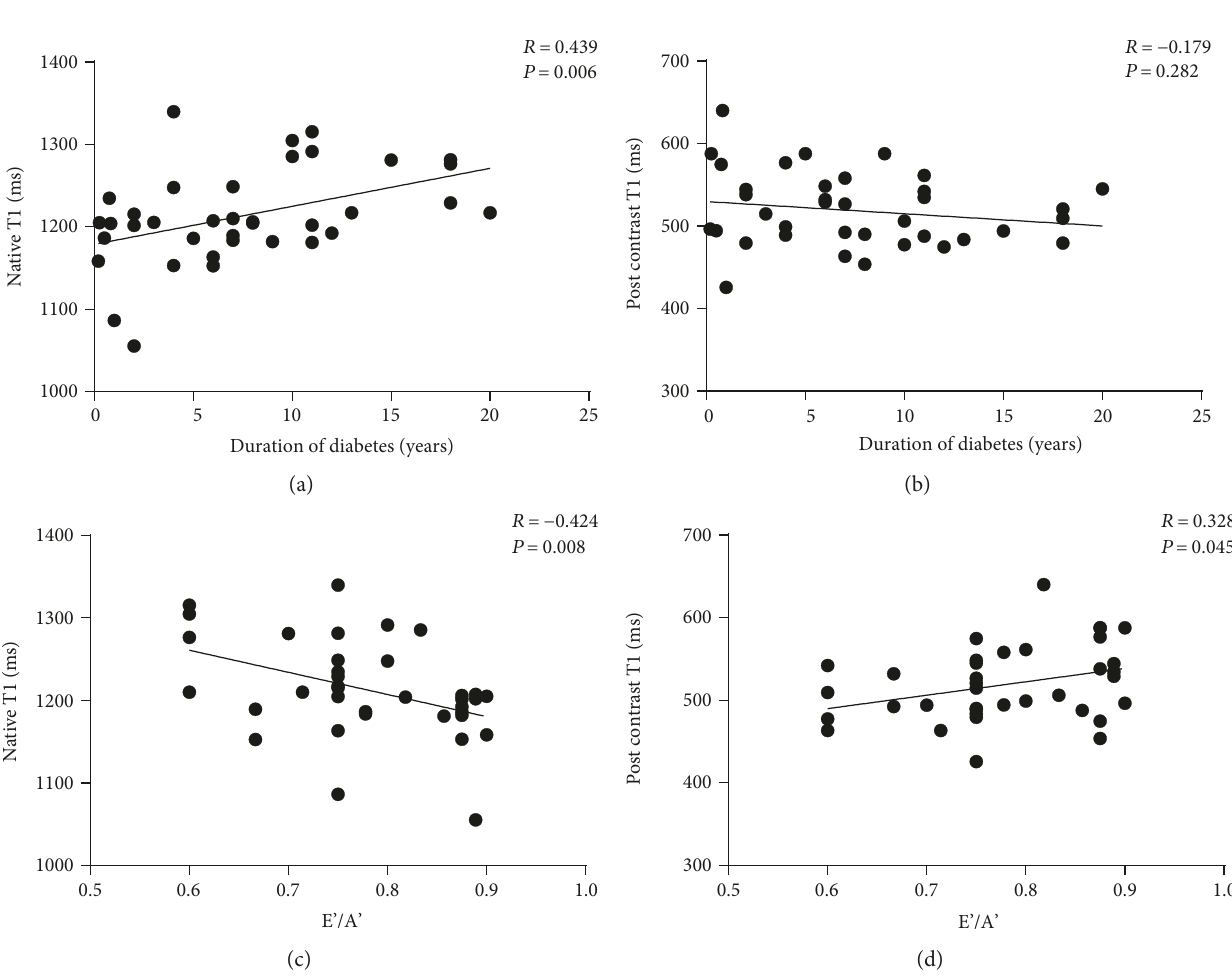
Figure 4: Correlations among myocardial T1 value, left-ventricular TDI E ’ /A ’ , and duration of diabetes. (a) Correlation between native myocardial T1 value and duration of diabetes. (b) Correlation between postcontrast myocardial T1 value and duration of diabetes. (c) Correlation between native myocardial T1 value and TDI E ’ /A ’ . (d) Correlation between postcontrast myocardial T1 value and TDI E ’ /A ’ Table 4: Left-ventricular myocardial T1 value and extracellular volume in controls and DbCM patients. Controls